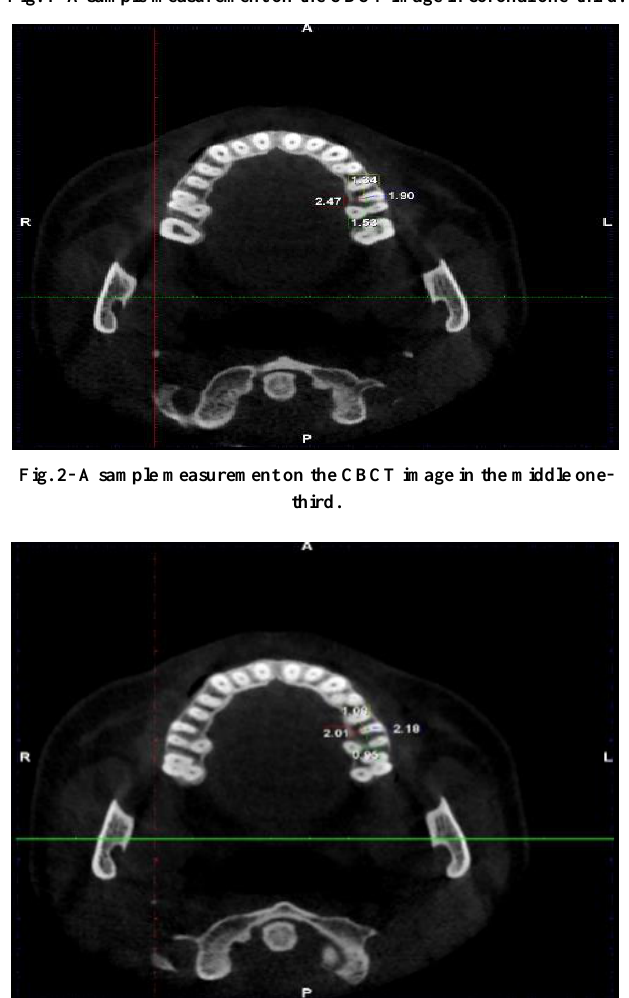
Fig. 1- A sample measurement on the CBCT image in coronal one-third.